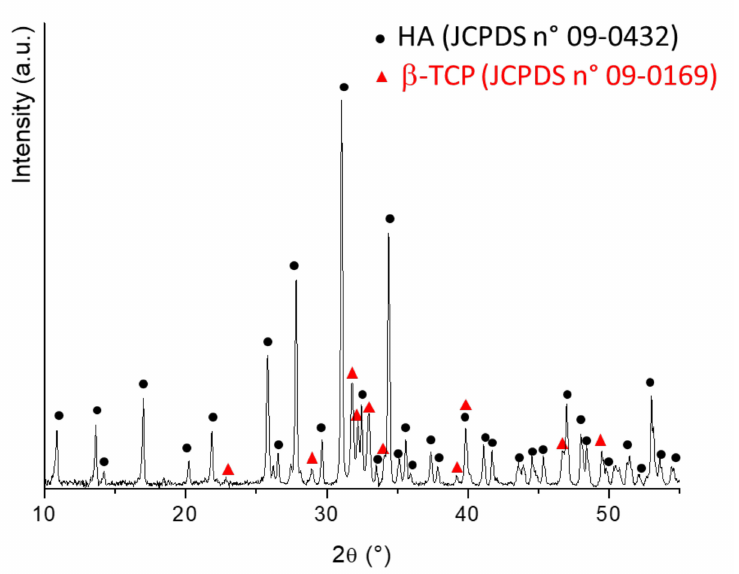
Figure 14. XRD pattern of the BCP mixture, showing that it is purely composed of the HA and β -TCP phases. Eight different scaffold types were obtained: pure PCL, BCP/PCL, PCL + Ag,